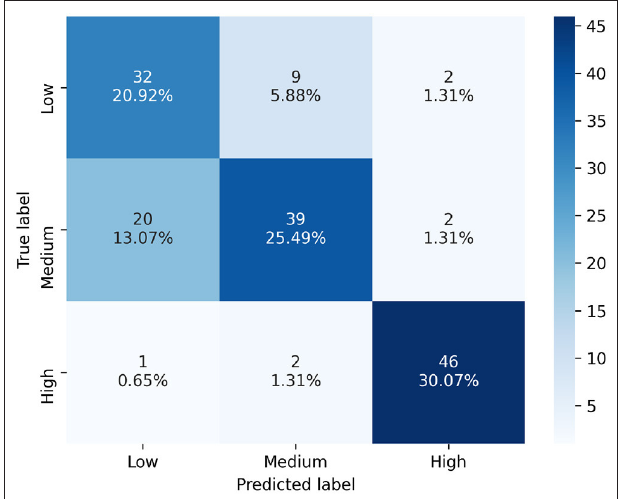
FIGURE 9 | Confusion matrix of the best model’s predictions for classifying task difficulty, using the three signals (EDA + ECG + RESP) and a task performance threshold of 100. Labels : Low = No task; Medium = 1-back task; High = 3-back task.